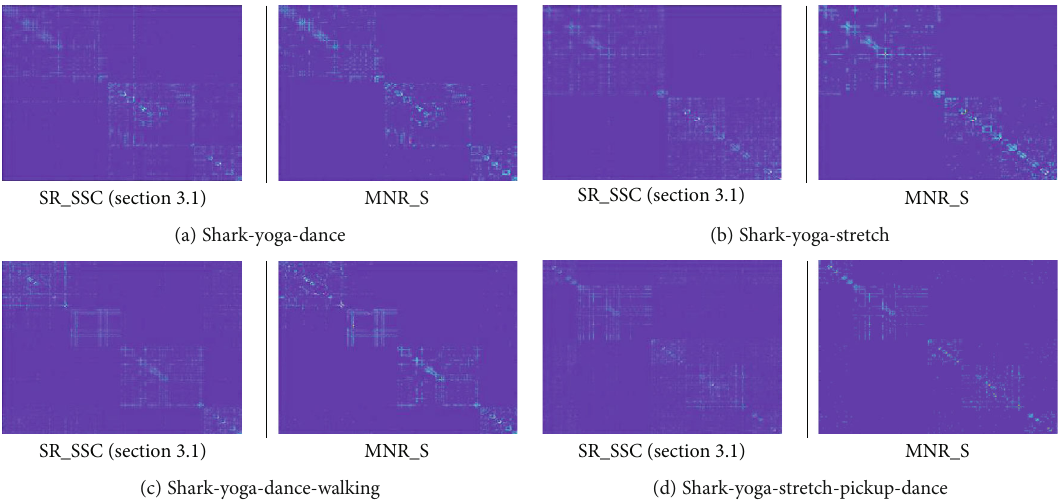
Figure 5: The a ffi ne matrix obtained by our algorithm and SR_SSC (Section 3.1).